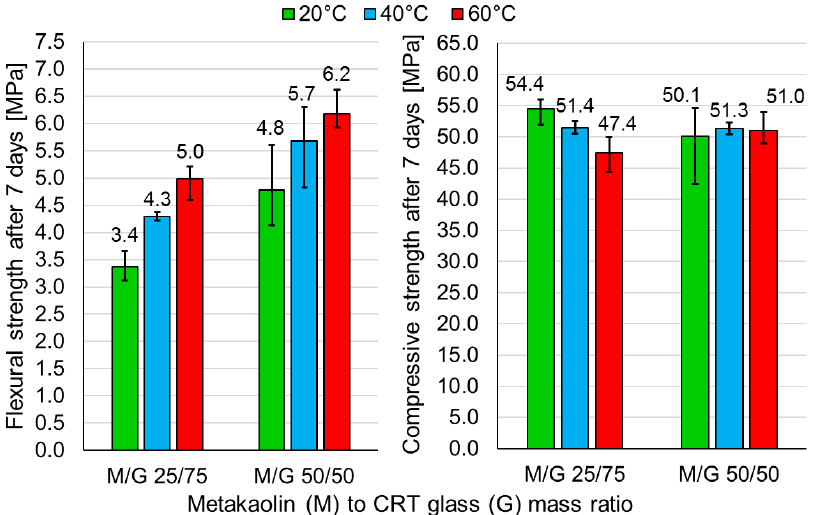
Figure 5. Flexural and compressive strengths of geopolymers of different metakaolin-to-CRT-glass ratios cured at different temperatures.